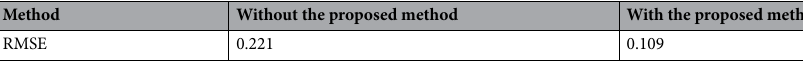
Table 1. Quantitative comparison of the metal product 1 (RMSE).